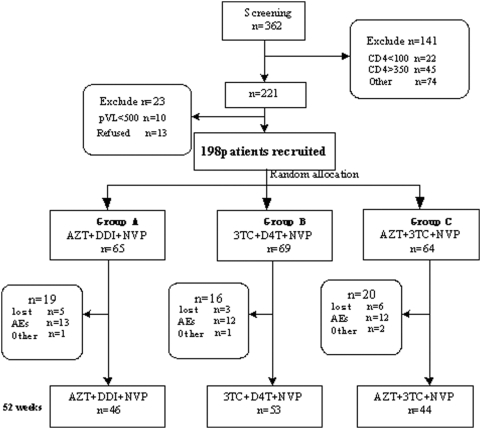
Disposition of patients (AZT, zidovudine; ddI, didanosine; NVP, nevirapine; 3TC, lamivudine; d4T, stavudine)